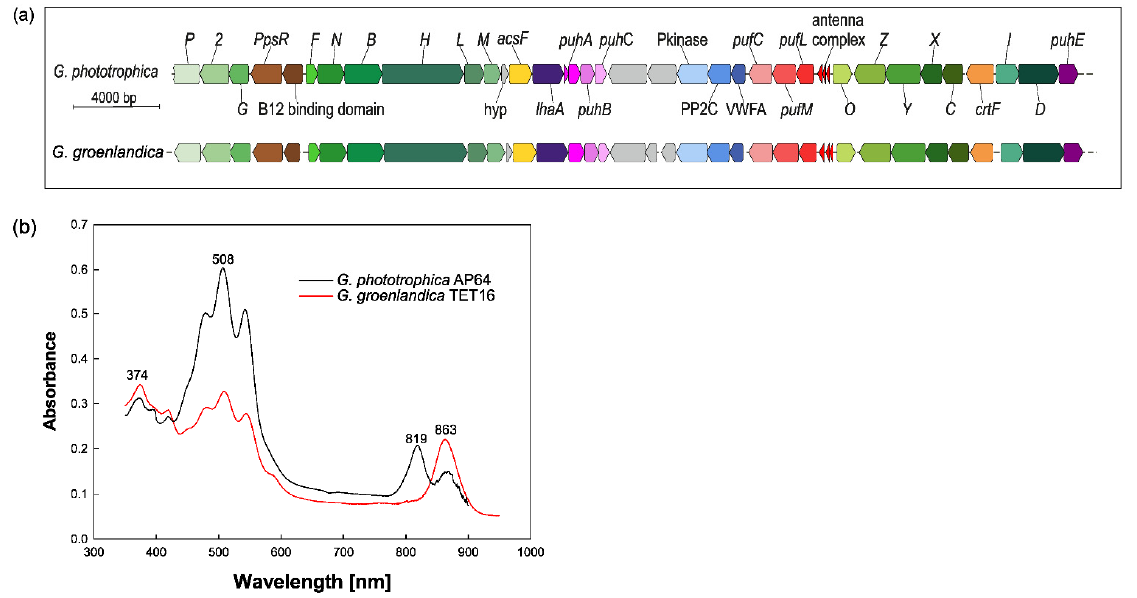
Figure 4. ( a ) Photosynthesis gene cluster of two cultured species of Gemmatimonadota, G. phototrophica and G. groenlandica . Different colors indicate genes involved in bacteriochlorophyll biosynthesis (green), carotenoid biosynthesis (orange), genes encoding the reaction center ( puf operon-red), puh operon (pink/purple), other genes (brown and yellow), genes not involved in photosynthesis (blue), and hypothetical genes (gray). The figure was adapted from ref. [18]. ( b ) Ab- sorption spectra of two cultures G. phototrophica (black) and G. groenlandica (red). In the near-infra-red range, G. phototrophica shows two peaks and G. groenlandica has only one. The figure was adapted from ref.